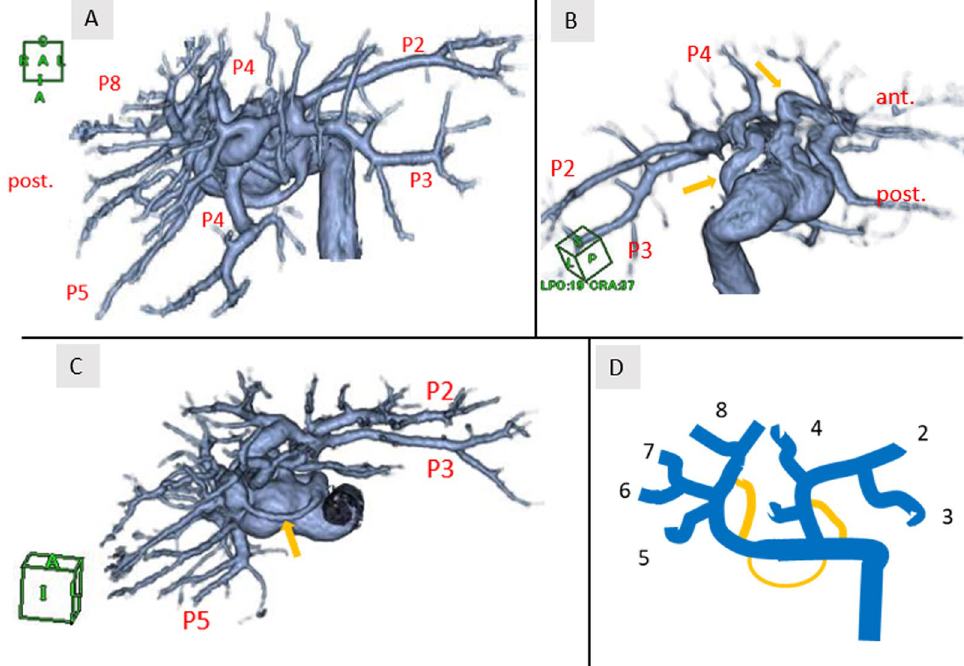
Fig. 4 A – C Volume rendering 3D reconstruction of computed tomography (focused on hepatic hilus). The image shows the complex branching pattern of the portal vein and some porto-portal communications (yellow arrow). D Scheme illustrates portal vein branching and the yellow line indicates porto-portal